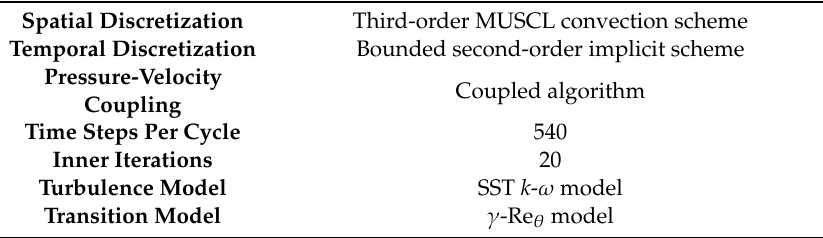
Table 2. Main settings of the URANS simulations.